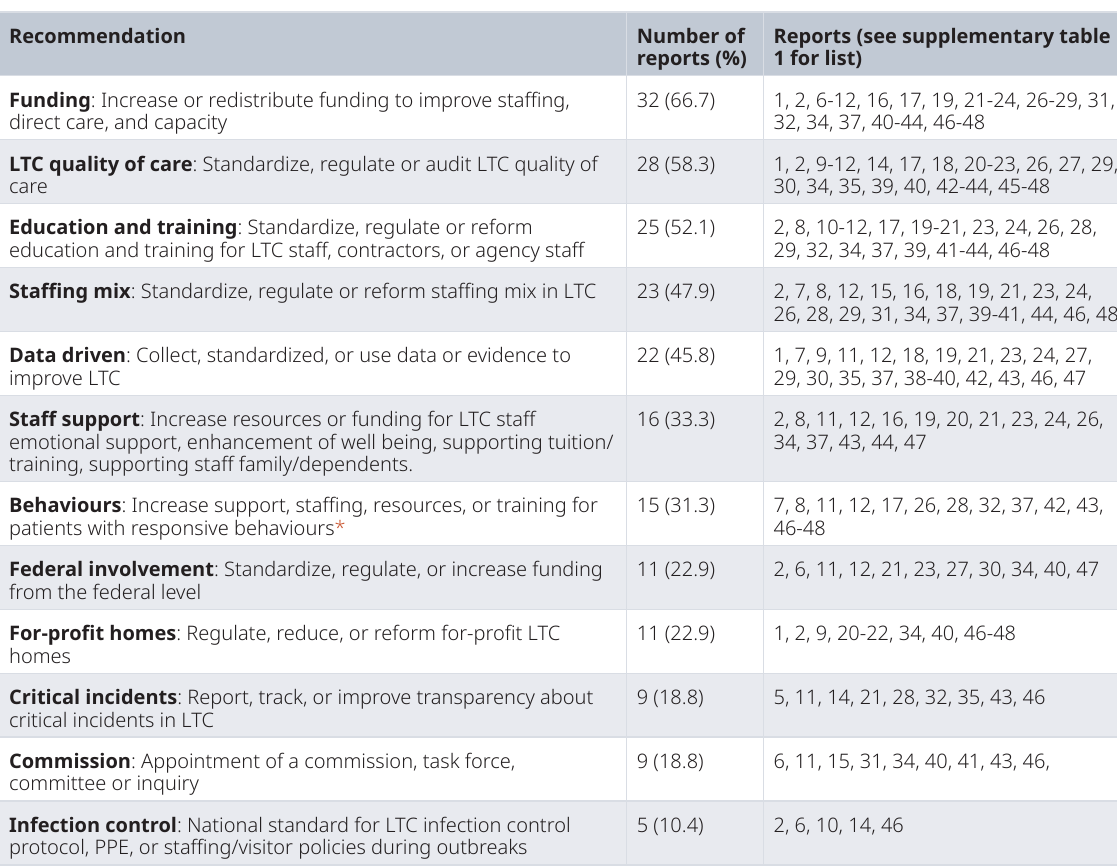
Table 2. Recurrent recommendations in long-term care (LTC) reports in the years 2010-2020 (n=48). Reports 1–10 are from after the COVID-19 pandemic and 11–48 are from before the pandemic. The full list of reports is available in Extended data , Supplementary Tables 1 and 2 14